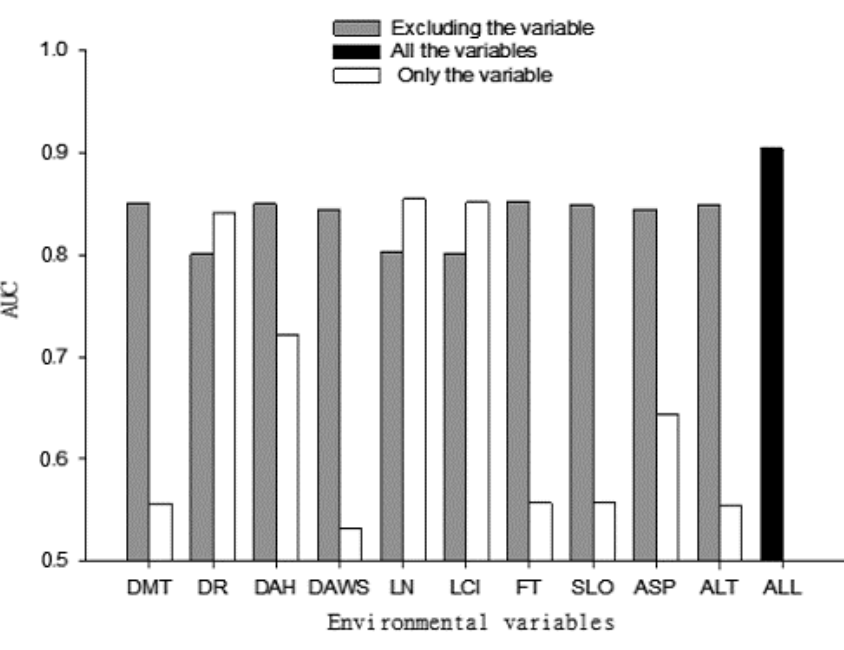
Figure 3. The relative contribution of environment variables to the model according to the AUC value method (AUC is the area under the curve of the sensitivity vs. 1—Specificity plot; codes for the variables are as given in Table